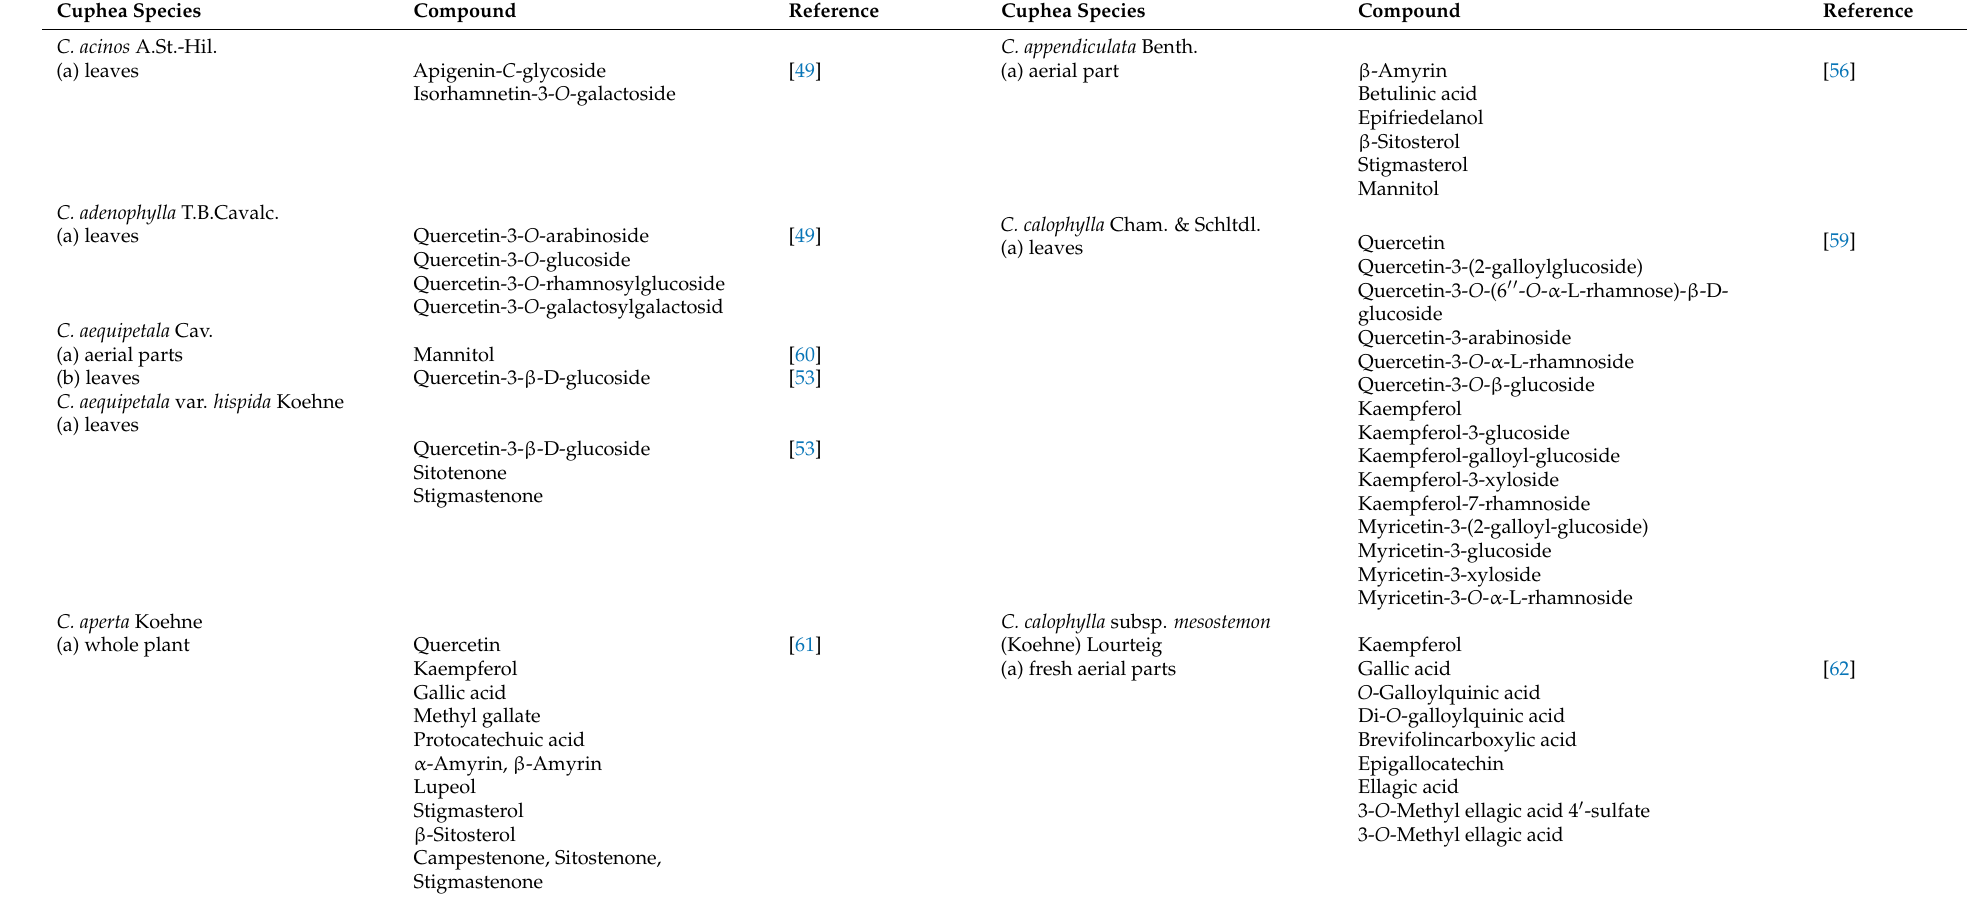
Table 2. Compounds reported in the genus Cuphea